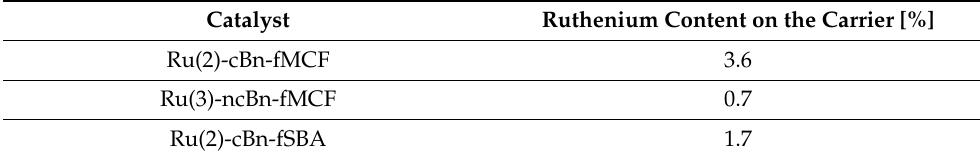
Table 7. Ruthenium content on silica supports measured by ICP-OES